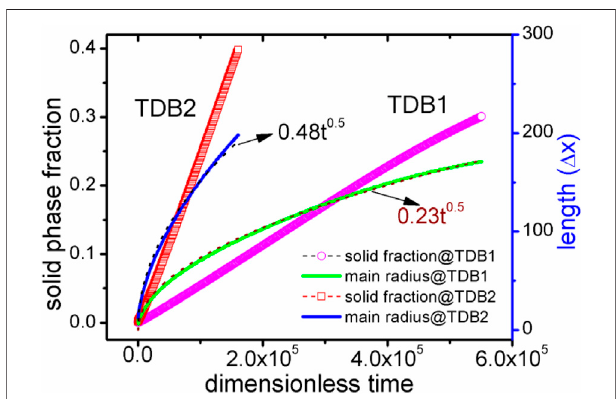
FIGURE 9 | (color online) Solid phase fraction and main radius curves with time for the two TDBs. The dotted lines represent the results of nonlinear fi tting using the formula R (cid:3) kt 0.5 main